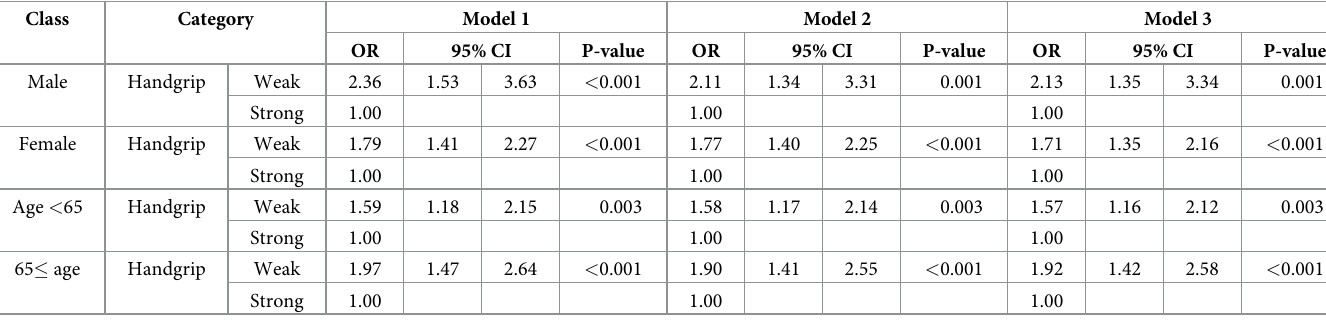
Table 5. Association between handgrip and anemia by